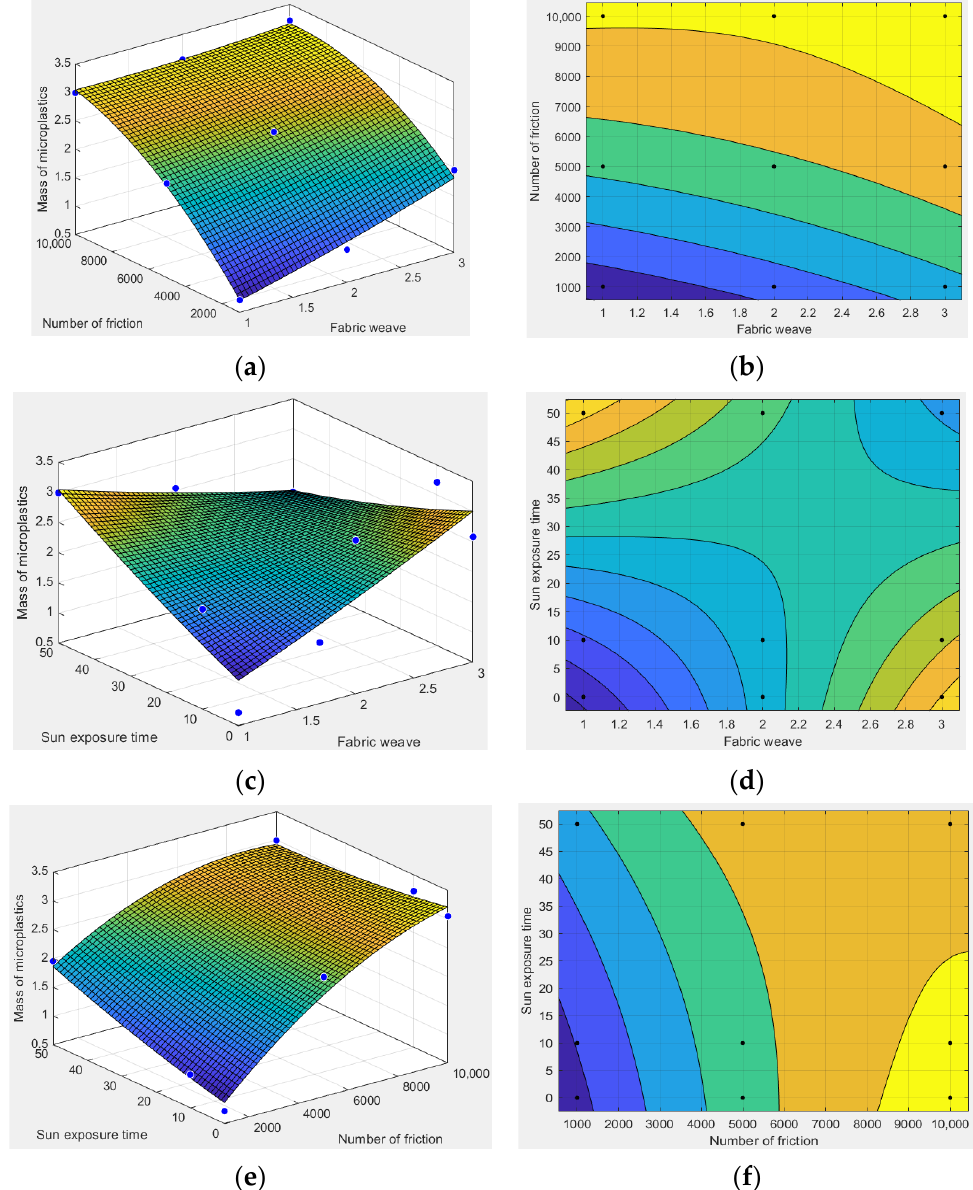
Figure 7. ( a ) Three-dimensional surface diagram of fabric structure and amount of friction; ( b ) contour plot of fabric structure and amount of friction; ( c ) three-dimensional surface diagram of fabric structure and insolation time; ( d ) three-dimensional surface diagram of fabric structure and insolation time; ( e ) three-dimensional surface diagram of the amount of friction and sunshine duration; ( f ) contour plot of the amount of friction and sunshine duration. ( The blue dots and black dots in the figure represent the positions of the values of the 9 experimental points respectively).